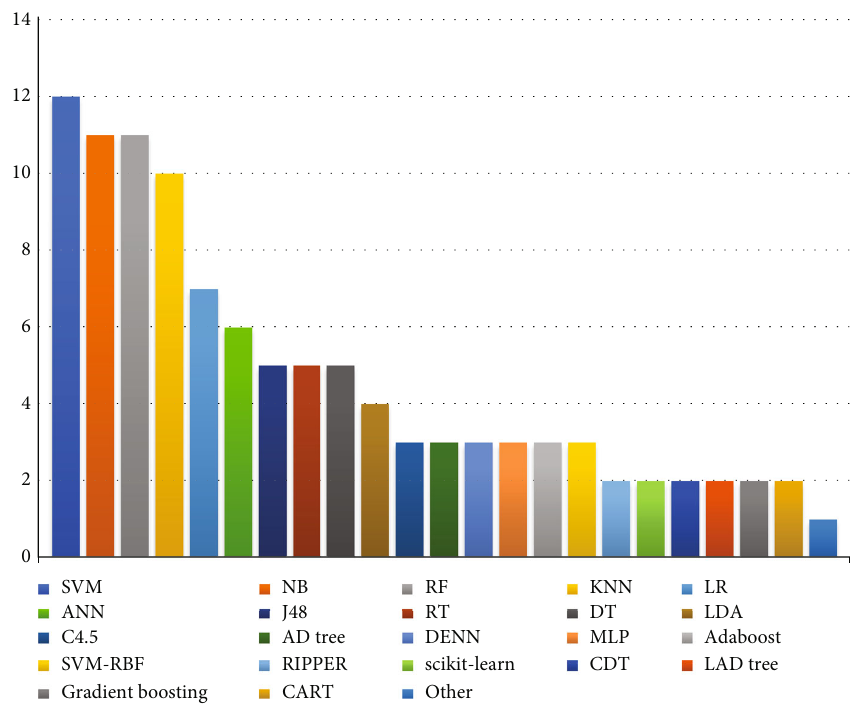
Figure 10: Description of ML algorithms used in the